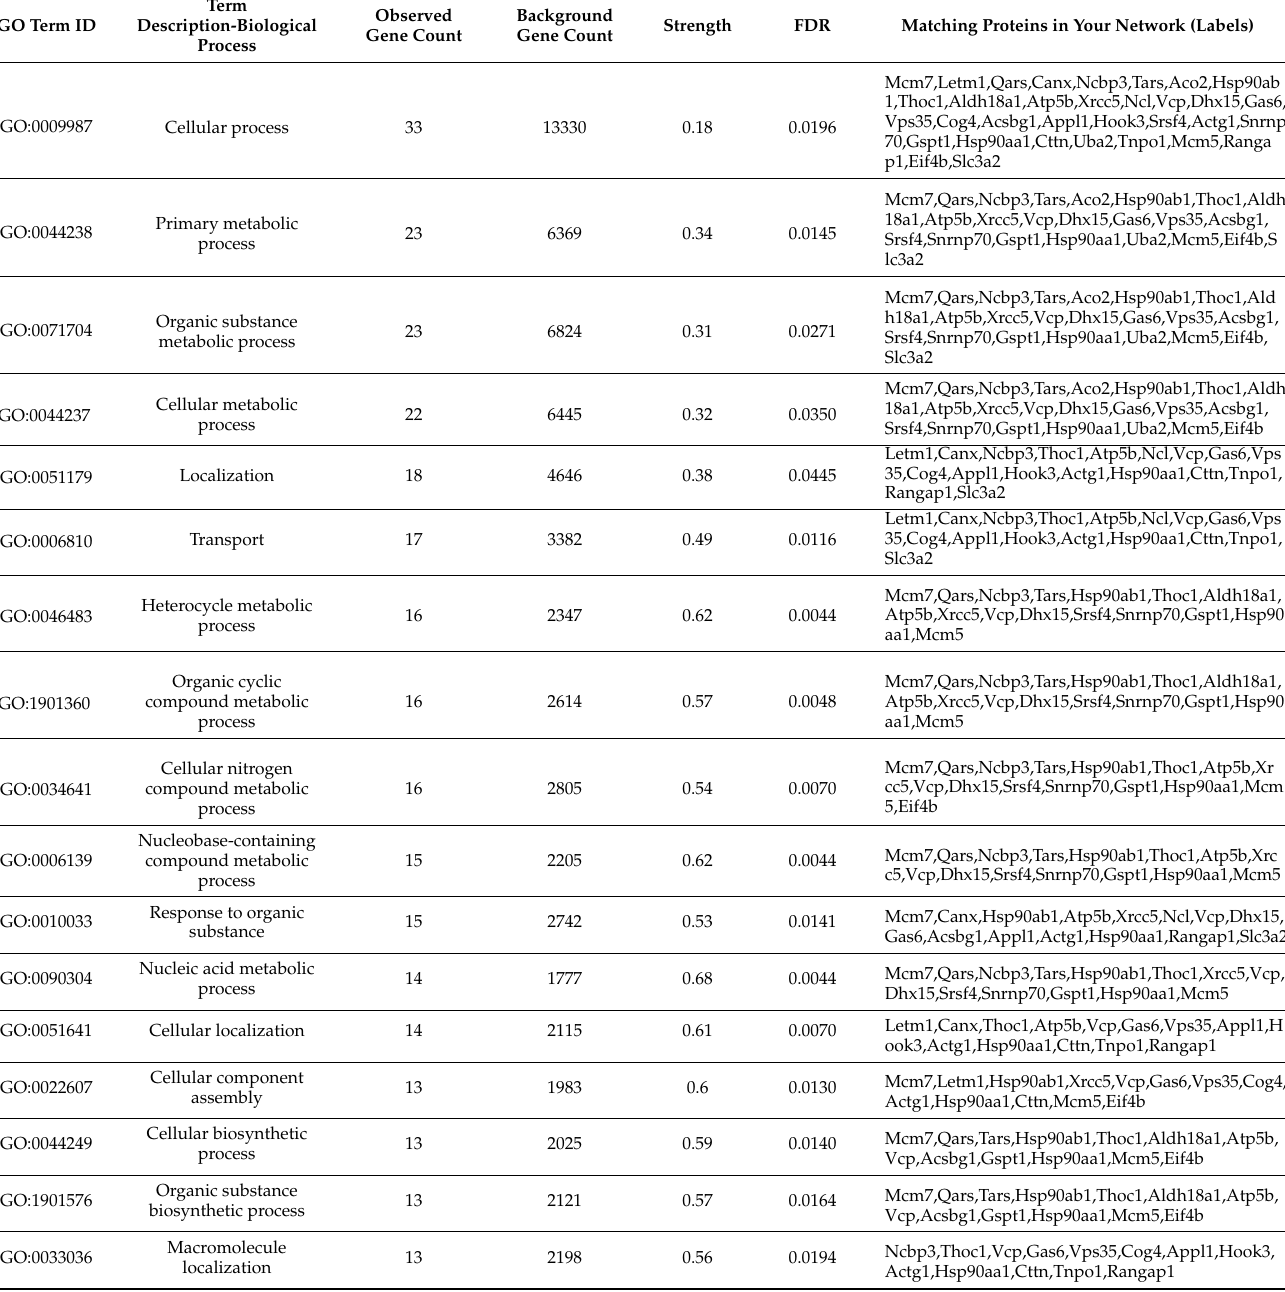
Table 2. Biological processes associated with proteins present in Sample